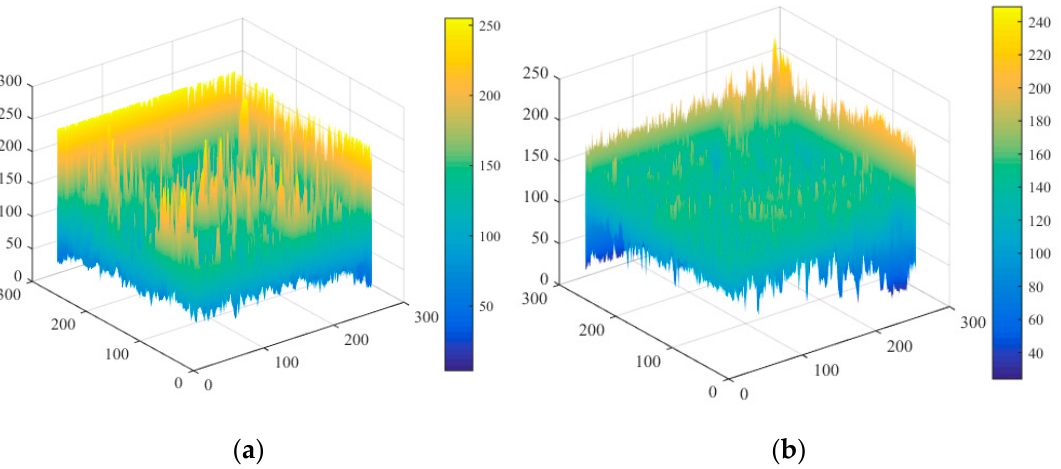
Figure 9. Surface plot of SEM gray scale images: ( a ) Steel slag; ( b ) Basalt.